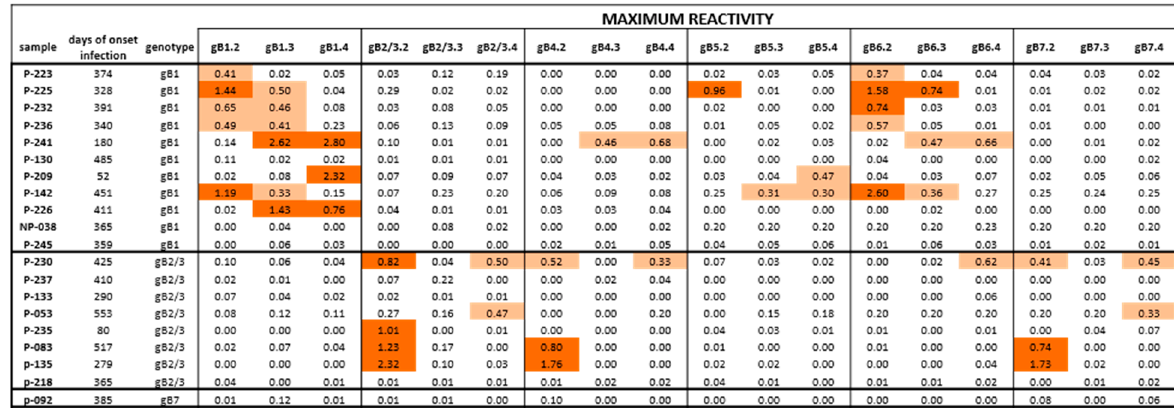
Figure 4. Maximum IgG antibody reactivity (OD value) against peptides of different gB genotypes in subjects with HCMV primary infection. Positive responses are highlighted in light orange for low reactivity (<0.70 OD) or dark orange for high reactivity (>0.70 OD). Some subjects infected by gB1 showed a cross-reactivity in particular with gB5 and gB6 and no response to gB2/3. Subjects infected by gB2/3 showed a cross reactivity to gB4 and gB7 and no response to gB1 and gB5. The only pregnant women typed as gB7 had no antibody response against gB7 or other genotypes.